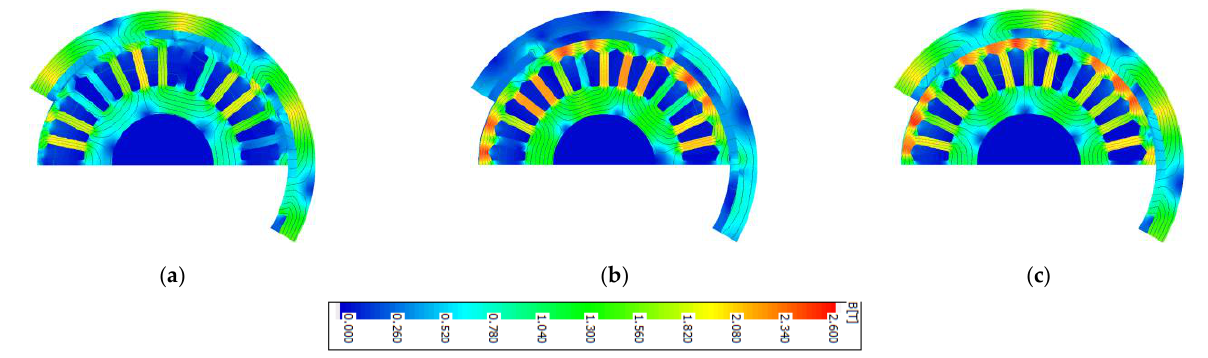
Figure A1. Flux density distribution in the initial models: ( a ) 42/6 and q = 1, ( b ) 28/6 and q = ⅔, ( c ) 21/6 and q = ½ , ( d ) 14/6 and q = ⅓.